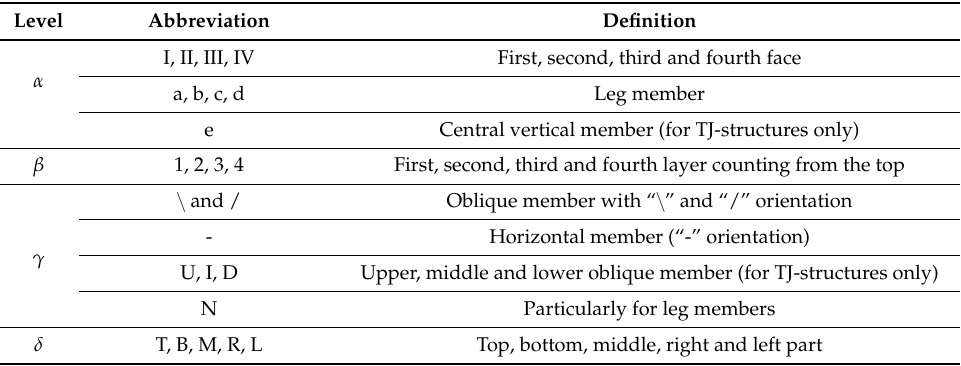
Table 1. Abbreviations for jacket structure members and